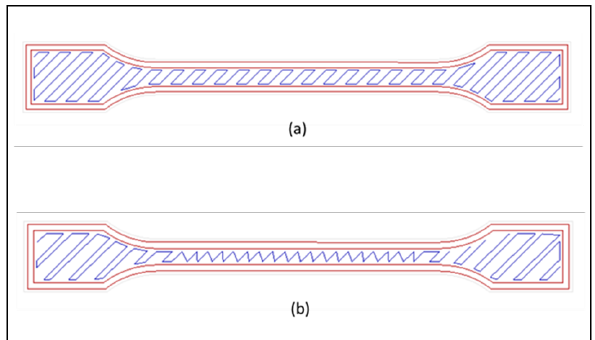
Figure 2. Different printing patterns (Image from Slicer software, [19]). ( a ) Rectilinear and ( b ) line.